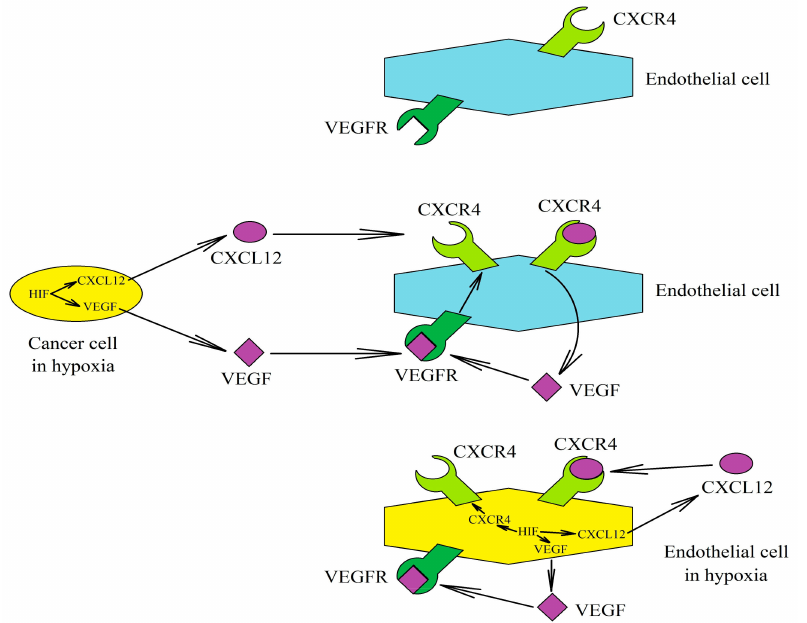
Figure 4. Association between the CXCL12 → CXCR4 axis and vascular endothelial growth factor (VEGF) in angiogenesis induced by chronic hypoxia. Chronic hypoxia increases the expression of VEGF and CXCL12 in a cancer cell, factors that act on endothelial cells. VEGF increases the expression of CXCR4 and thus enhances the sensitivity of these cells to CXCL12. In turn, CXCL12 causes an increase in VEGF expression in endothelial cells. In addition, chronic hypoxia itself can act directly on endothelial cells. It increases the expression of CXCR4, CXCL12 and VEGF, which act in an autocrine manner on these cells. As a result of the described factors, angiogenesis